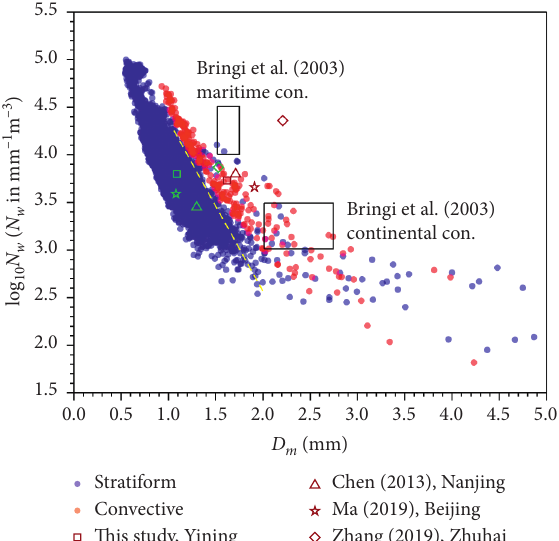
Figure 7: Average size spectra for convective (red line) and Figure 6: Scatterplot of log N D w versus m for convective rains stratiform (blue line) rain. 10 (red filled circles) and stratiform rains (blue filled circles). The two black rectangles correspond to the maritime and continental N − D convective clusters, and the yellow dashed line is the log w m 10 relationship for stratiform rain reported by Bringi et al. [28]. The squares represent the averaged values in this study. The triangles, circles, stars, and diamonds represent the averaged values obtained in previous studies by Chen et al. [24], Ma et al. [14], and Zhang et al. [48] for different parts of China. The colors of these symbols represent different rains: green for stratiform rains and brown for convective rains.